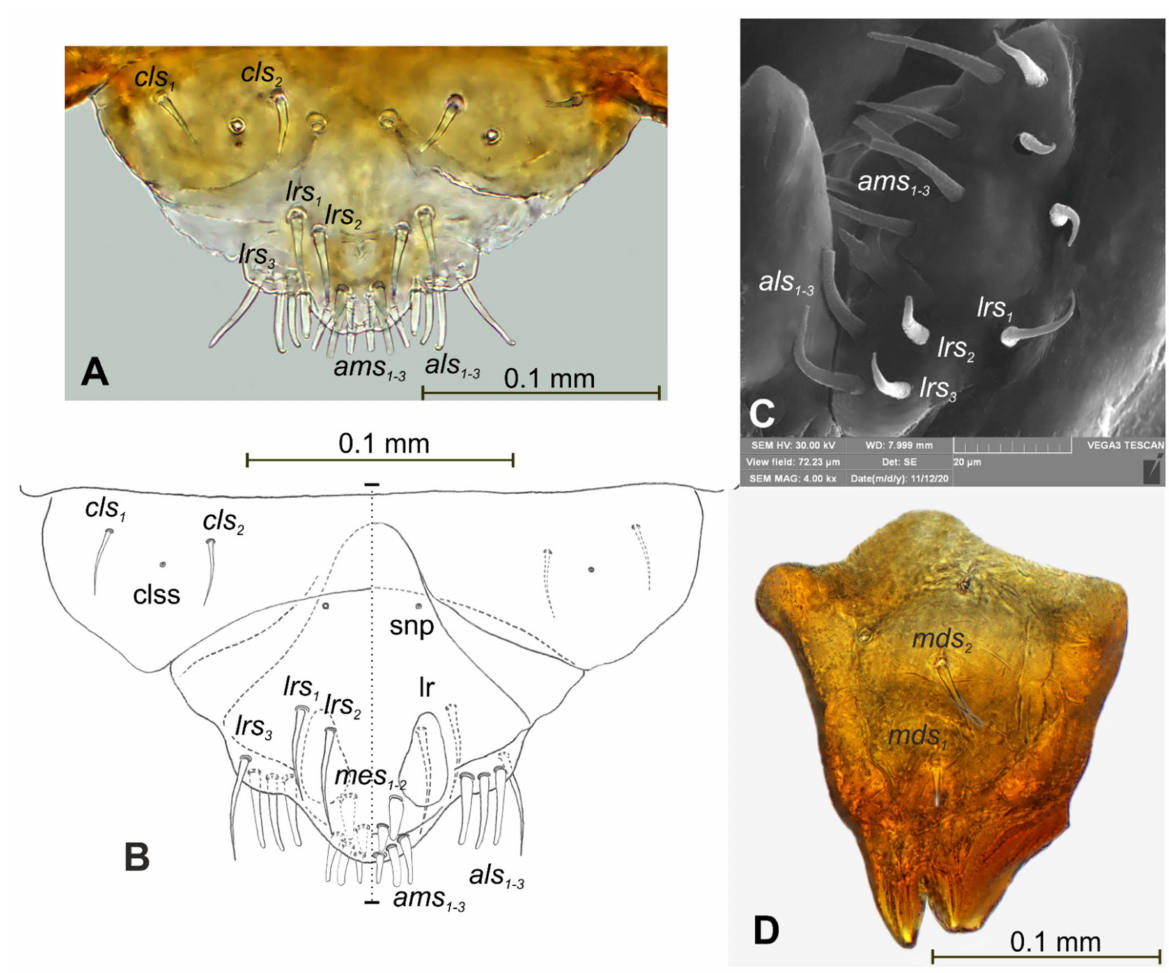
Figure 6. Lachnaeus crinitus mature larva, mouthparts. ( A )—clypeus, labrum, and epipharynx, photo; ( B )—clypeus, labrum and epipharynx, scheme; ( C )—clypeus, labrum, and epipharynx, SEM photo; ( D )—right mandible (clss—clypeal sensorium, lr—labral rods, snp—sensillae pore, setae: als —anterolateral, ams —anteromedial, cls —clypeal, lrs —labral, mds — mandibular , mes